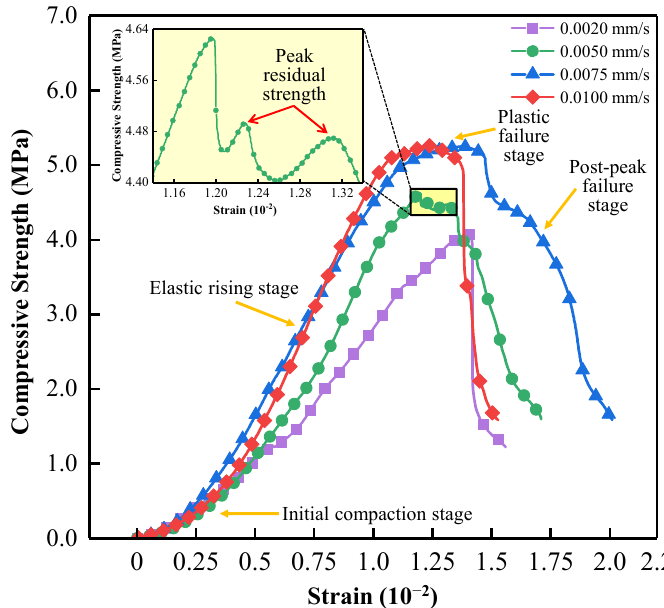
Figure 4. Stress–strain curve of ASPM specimen.